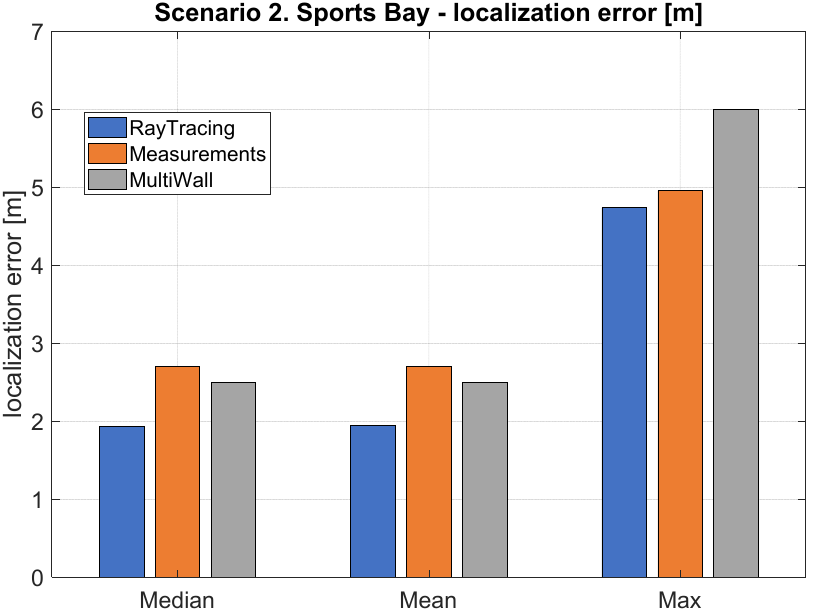
Figure 17. Localization error for the sports hall in the “Sports Bay” at Lodz University of Technology. Data obtained using reference RSSI datasets prepared by different methods.